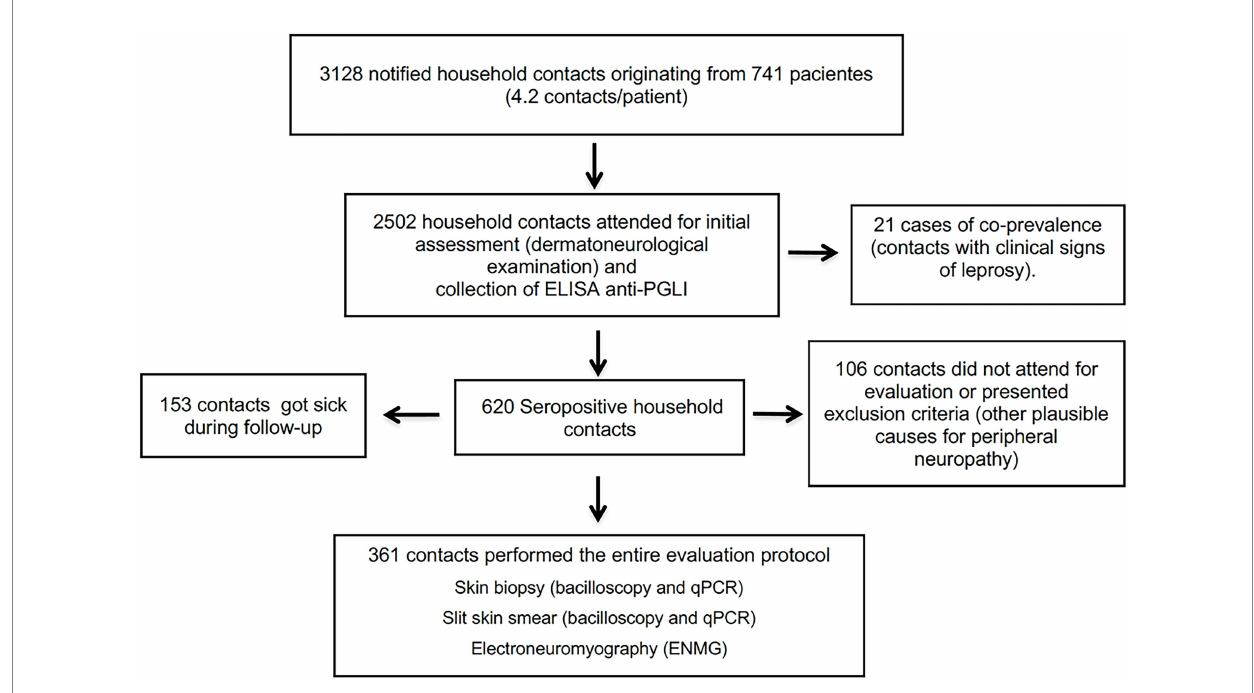
FIGURE 1 Algorithm proposed for household leprosy contacts